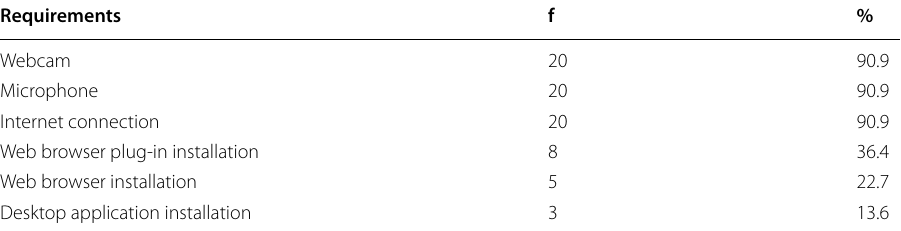
Table 11 Hardware or software requirements in online assessment systems